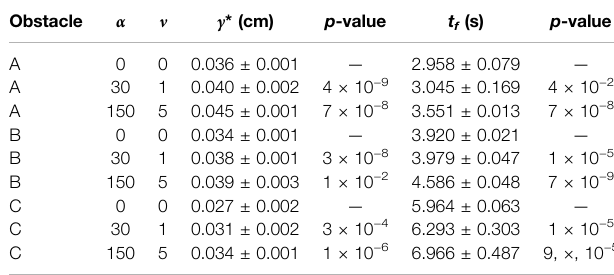
TABLE 1 | Summary of optimized trajectories over 50 different initializations. The median time ( t f ) and 95% translation threshold ( γ *) ± their interquartile range are reported among the instances that converged. The p -values come from testing the changeof t The p -values were adjusted with Bonferonni corrections for the multiple tests done on γ * and t f ,